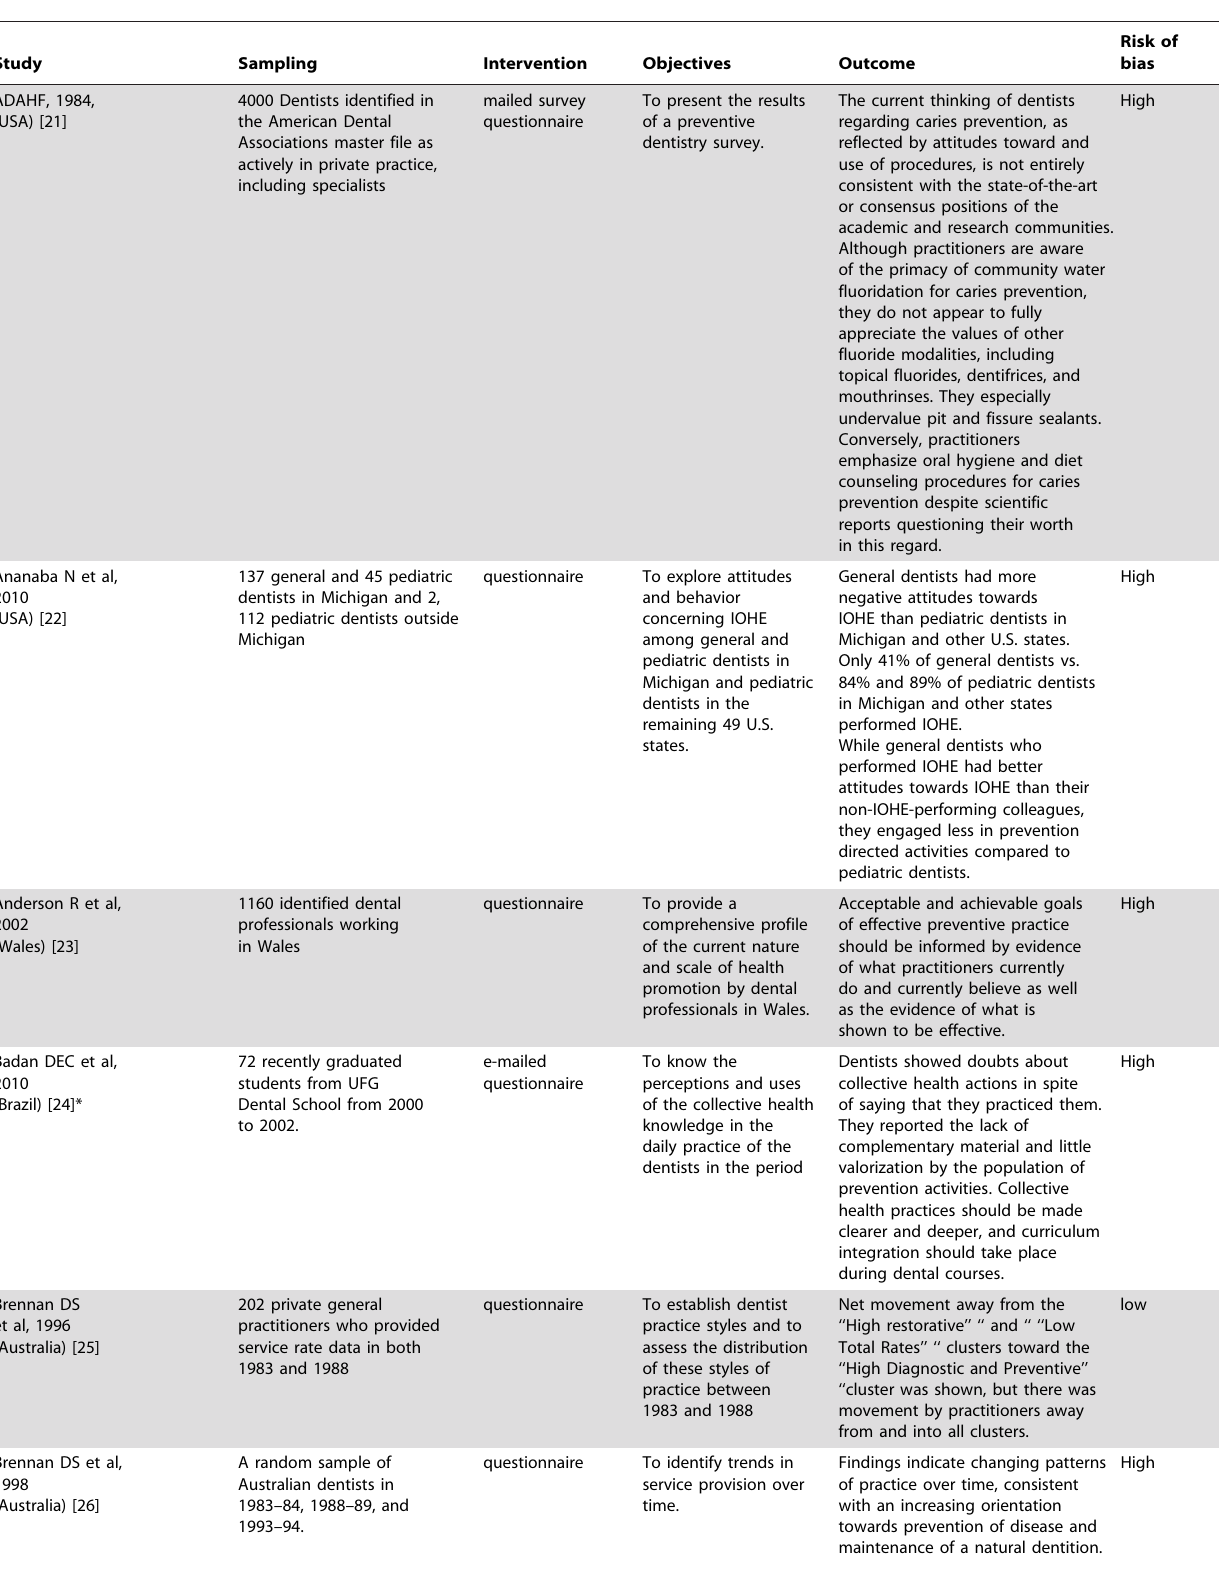
Table 2. Publication characteristics of the surveys included in the